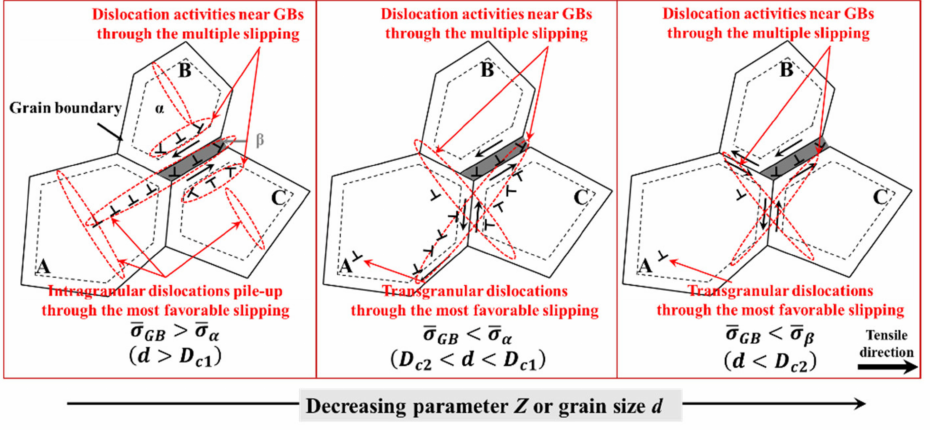
Figure 16. Schematic of transformative accommodation mechanisms of dislocation motion associated with GBS under different hot deformation conditions of near- α titanium